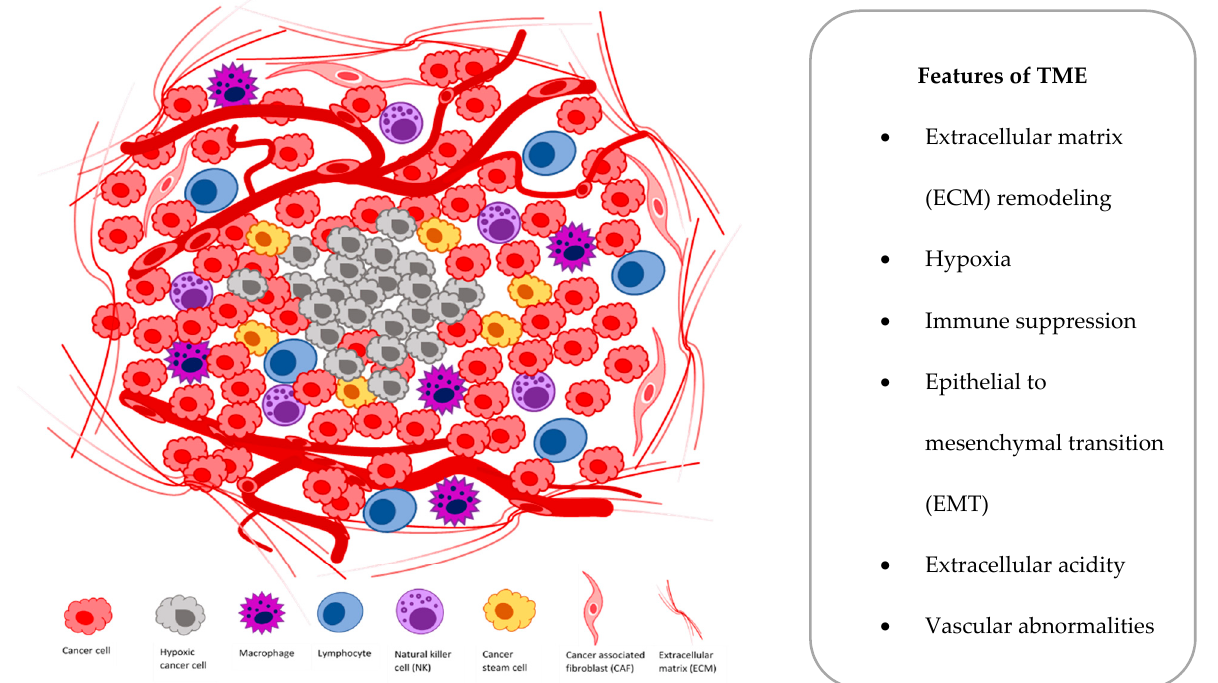
Figure 1. Main components and features of the tumor microenvironment (TME).